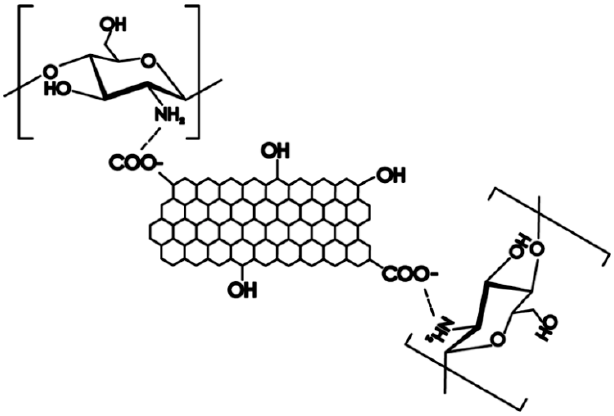
Figure 1. Molecular schematic diagram of amidation reaction.